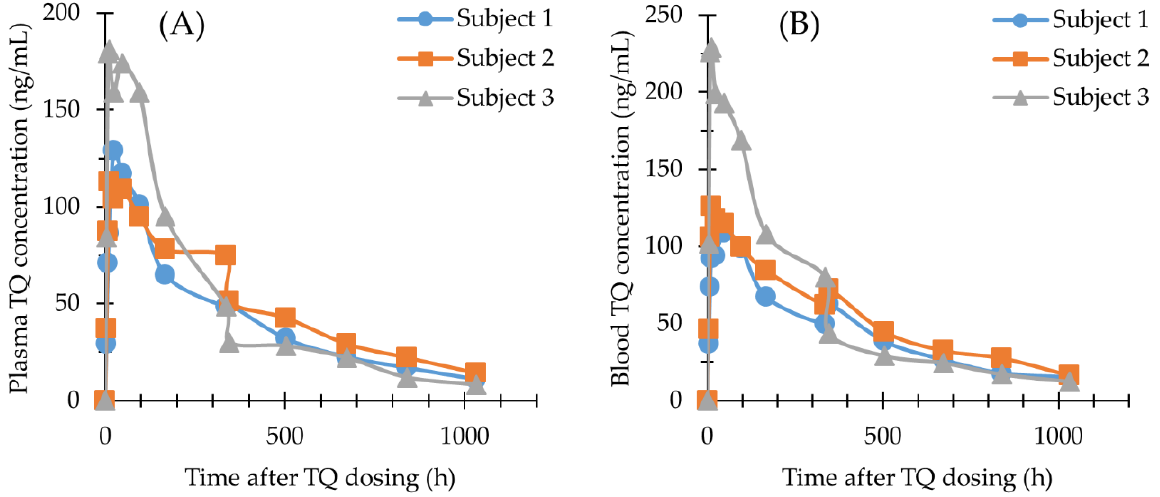
Figure 3. TQ concentration—time profiles in human plasma ( A ) and human blood ( B ) from three subjects given 200 mg TQ orally; Subject 1, (circle line); Subject 2, (square line); Subject 3, (triangle line).